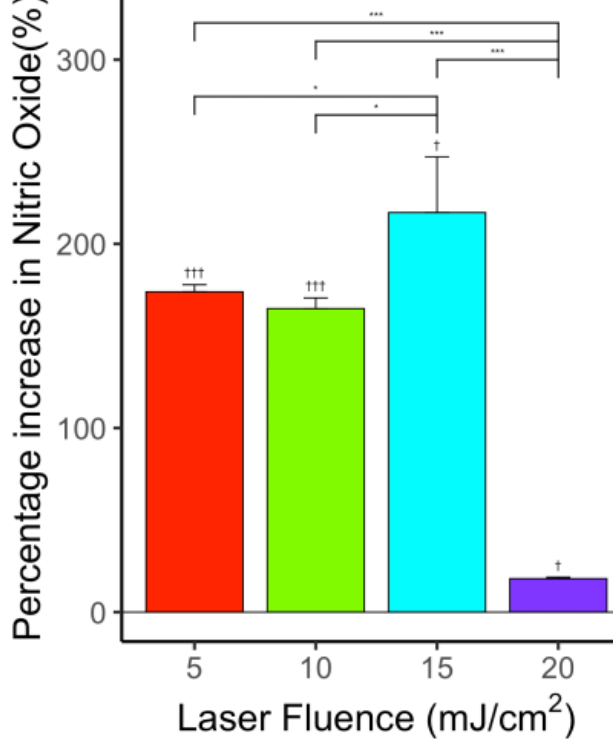
Figure 5. Effect of laser on NO levels for various levels of laser fluence—5, 10, 15 and 20 mJ/cm 2 — showing significant increase in NO levels compared to control. n = 6 for each group. “*” indicates statistical significance between groups with p < 0.05. “***” indicates statistical significance between groups with p < 0.001. “†” indicates statistical significance between control and treatment group p < 0.05. “†††” indicates statistical significance between control and treatment group p < 0.001.